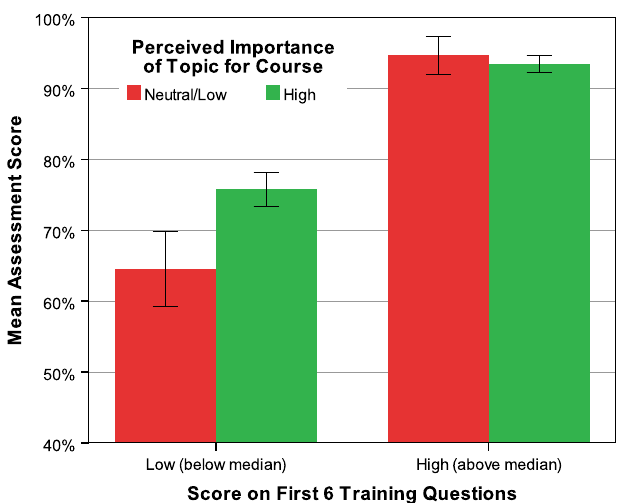
FIG. 11. Experiment 2 mean assessment scores by score on first 6 training questions (prescore), separated by perceived impor- tance of the topic for